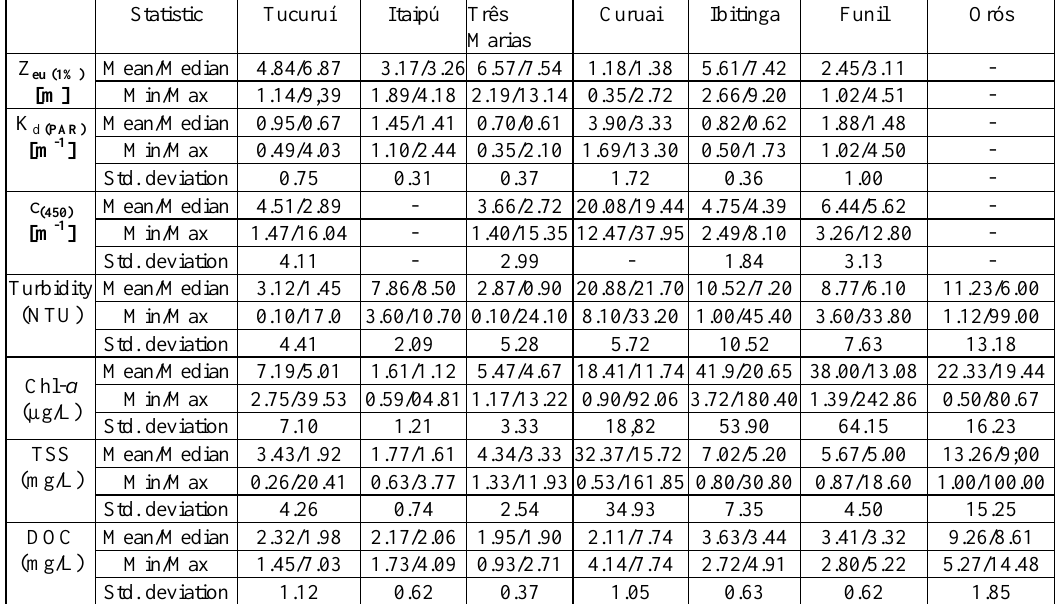
Table 2. Descriptive statistics of some bio-optical properties of Brazilian inland aquatic systems:, Z eu (1%) = lower limit of the euphotic zone, K d (PAR) = vertical attenuation coefficient for downwards irradiance of PAR (Photosynthetically Available Radiation), c (450) = beam attenuation coefficient in 450 nm, Chl- a = chlorophyll-a, TSS = Total Suspended Solid, DOC = Dissolved Organic